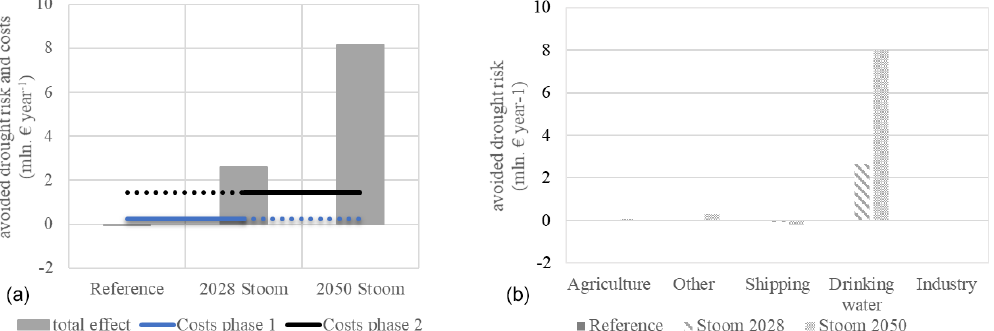
Figure 6. Comparison of costs and avoided drought risk of the advised strategy in the region Southwest. (a) Summary of costs and effects in the reference situation, in 2028 (Stoom) and in 2050 (Stoom). (b) Distribution of avoided drought risk over different user